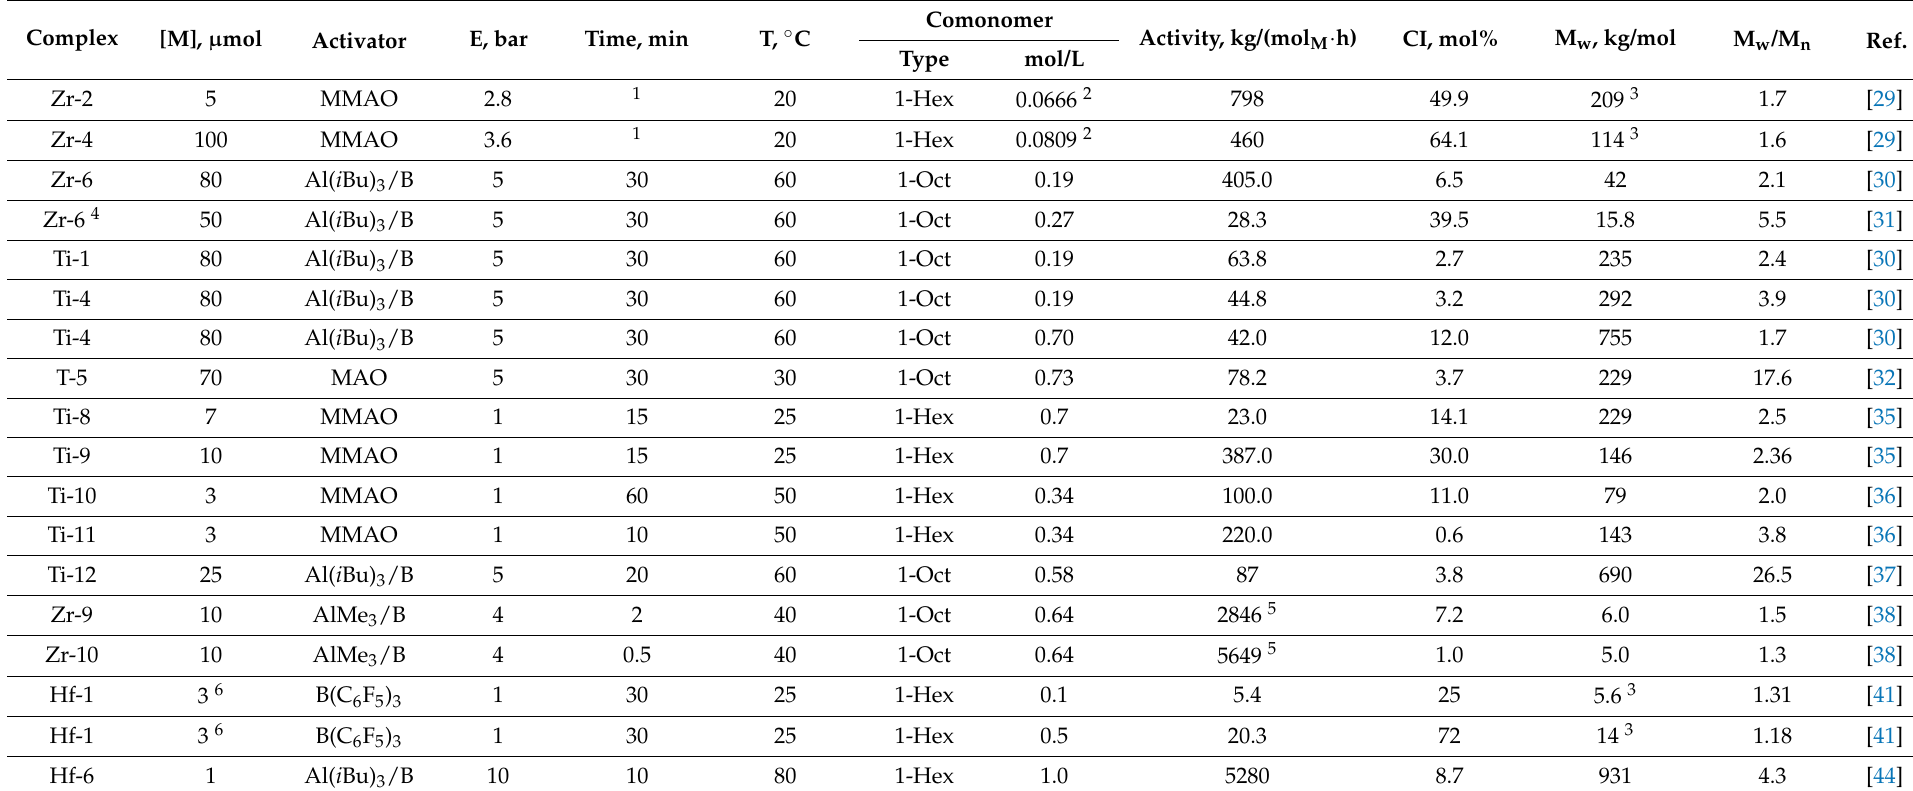
Table 4. Results of ethylene/1-olefin copolymerization with group 4 metal